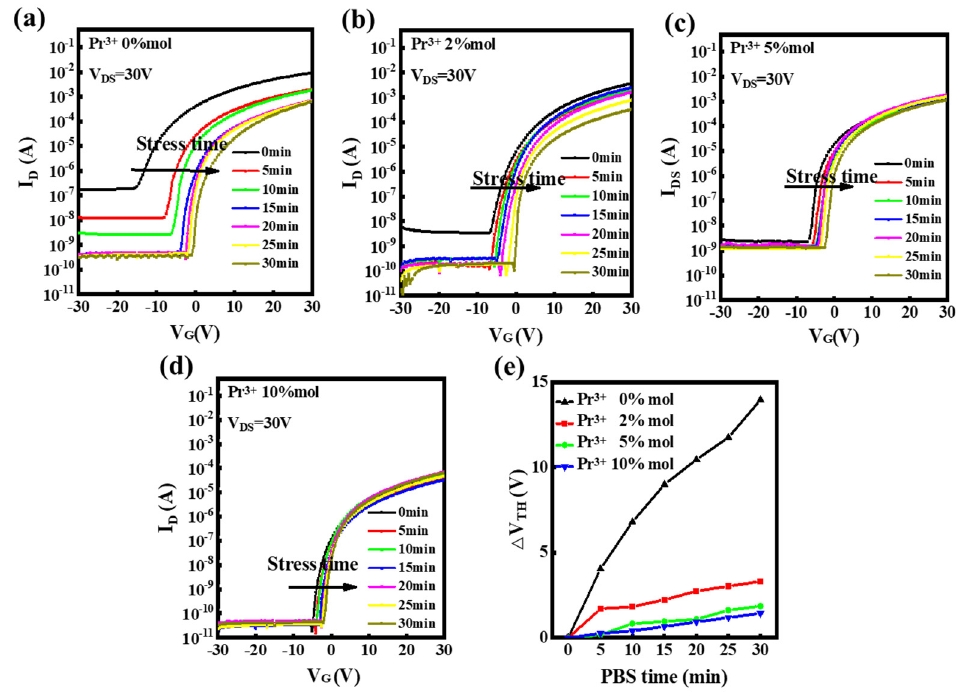
Figure 9. Transfer curves variations under positive bias stress for In-Pr-O TFTs with Pr mol% ratios of ( a ) 0 mol%, ( b ) 2 mol%, ( c ) 5 mol%, ( d ) 10 mol%, and ( e ) summary of V T shifts.